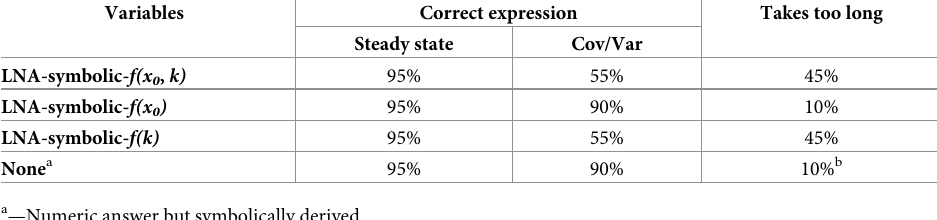
Table 6. Performance of BioSANS in generating LNA and a steady-state analytical